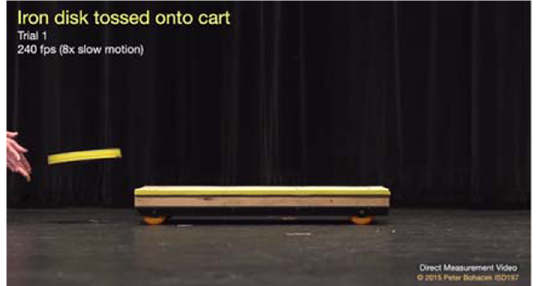
FIG. 3. An iron disk is tossed onto a cart where it bounces and slides. For the model-breaking assessment (Appendix B), students were asked if the total momentum of the disk and cart before the collision was the same as their combined momentum after the collision despite the obvious messiness of the collision itself